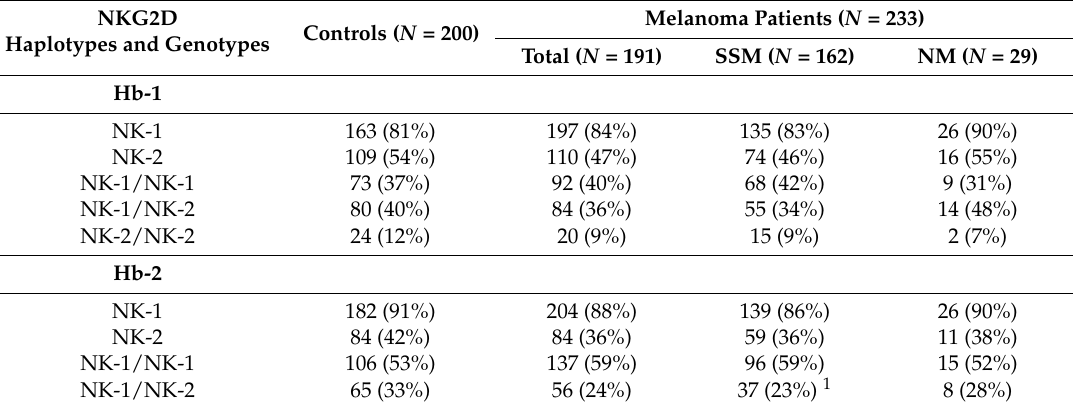
Table 7. Association between NKG2D haplotypes and genotypes with melanoma.